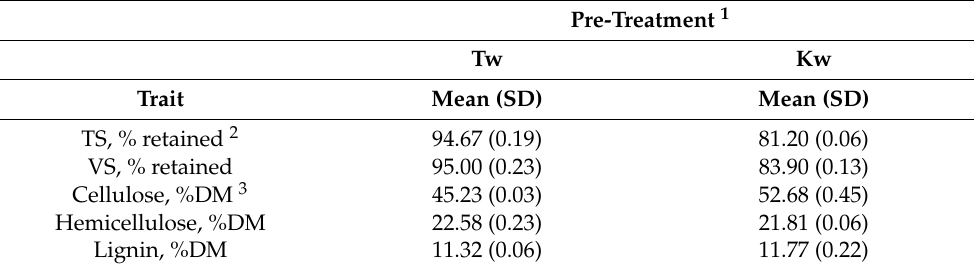
Table 3. Fiber composition of differently pre-treated giant reed after the washing